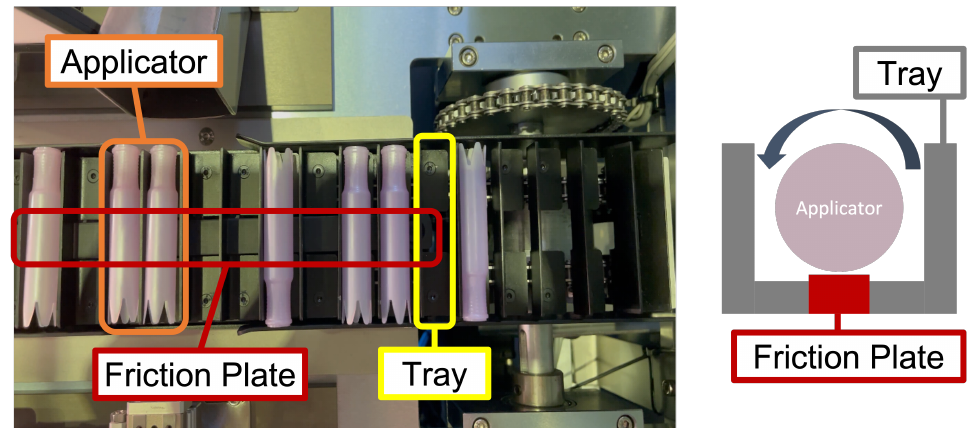
Figure 12. Design of tray conveyor with friction plate for data acquisition.